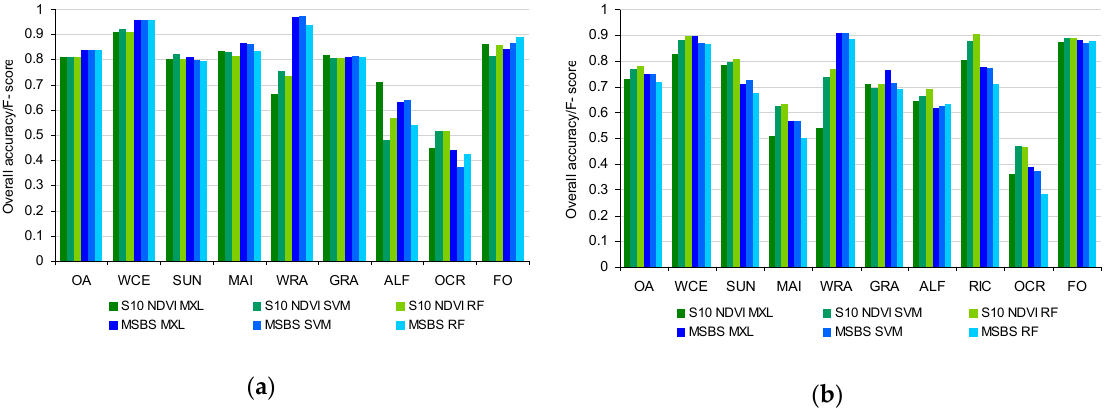
Figure 4. Overall accuracy (OA) and F -score per class for the crop/land-use maps of “Knezha” ( a ) and “Belozem” ( b ) test sites derived by different types of Sentinel-2 data (i.e., S10 NDVI time series and MSBS) and different classification method: MXL—maximum likelihood, SVM—support vector